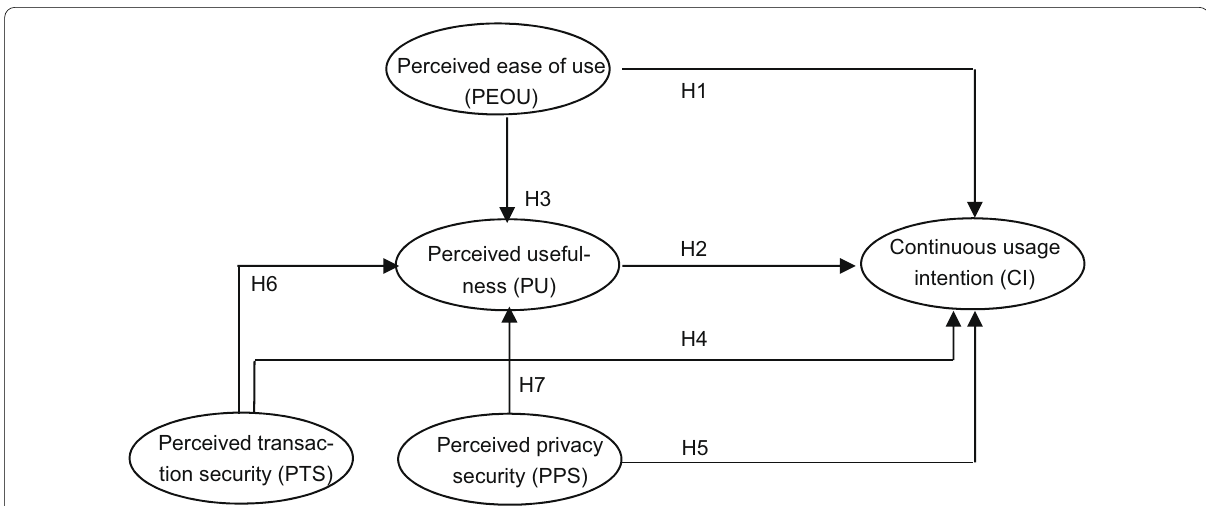
Fig. 2 Proposed research model for the continuous usage intention to e-transaction cards